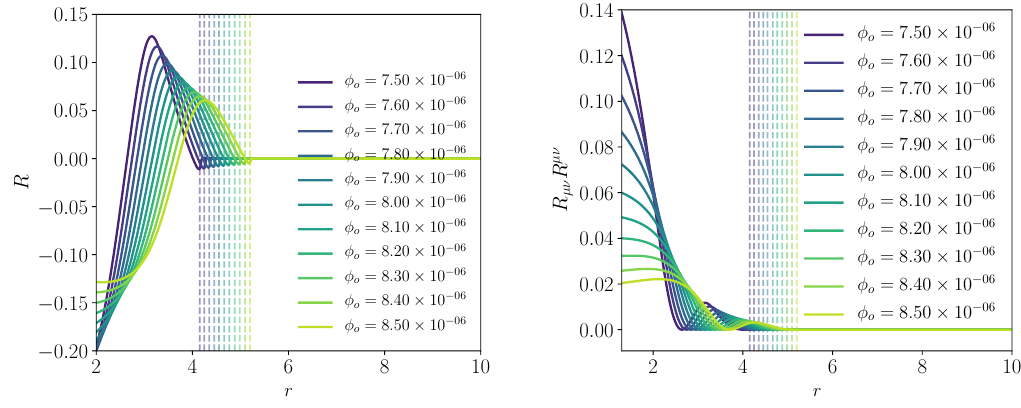
Figure 5 . Curvature scalar R and Ricci tensor squared R (cid:22)(cid:23) R (cid:22)(cid:23) as a function of the radial radius r at last time t before formation of the event horizon for (cid:12) = 10 and (cid:30) 0 corresponding to the last branch. The vertical line represents the position of the event horizon for each initial condition (cid:30) 0 . (cid:30) 0 which all correspond to the fourth branch where the event horizon forms at the